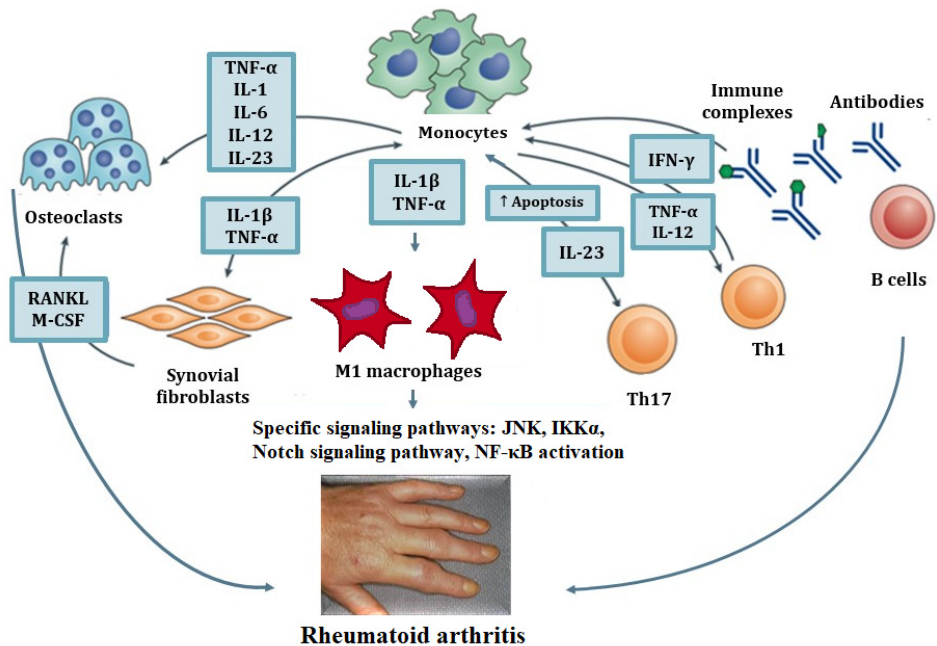
Figure 1. Involvement of macrophages in the development of rheumatoid arthritis. Macrophages produce cytokines that support inflammation by recruiting new immune cells (monocytes), polarizing T cells, and activating fibroblasts. Activated fibroblasts secrete receptor activator of nuclear factor kappa-B (NF- κ B) ligand (RANKL) and macrophage colony-stimulating factor 1 (M-CSF), which induce osteoclast differentiation, which is enhanced by TNF and other cytokines. The formed autoimmune complexes, in turn, activate macrophages. Macrophages are also affected by cytokines produced by T cells, fibroblasts, and innate immune